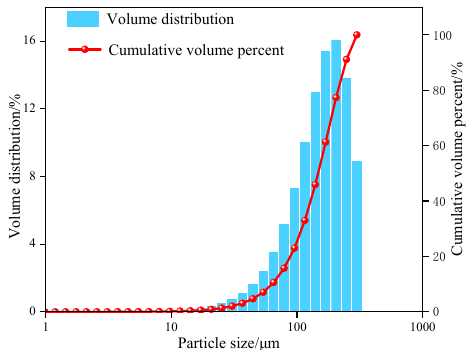
Figure 1. Particle size distribution of the tailings.